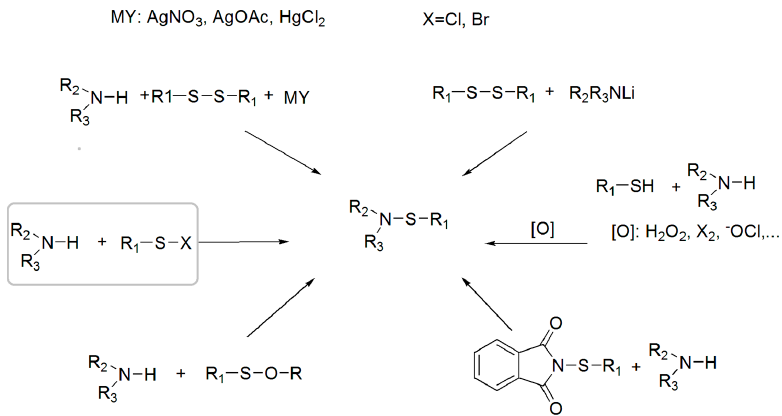
Figure 2. General synthetic methods developed for generating sulfenamide derivatives.